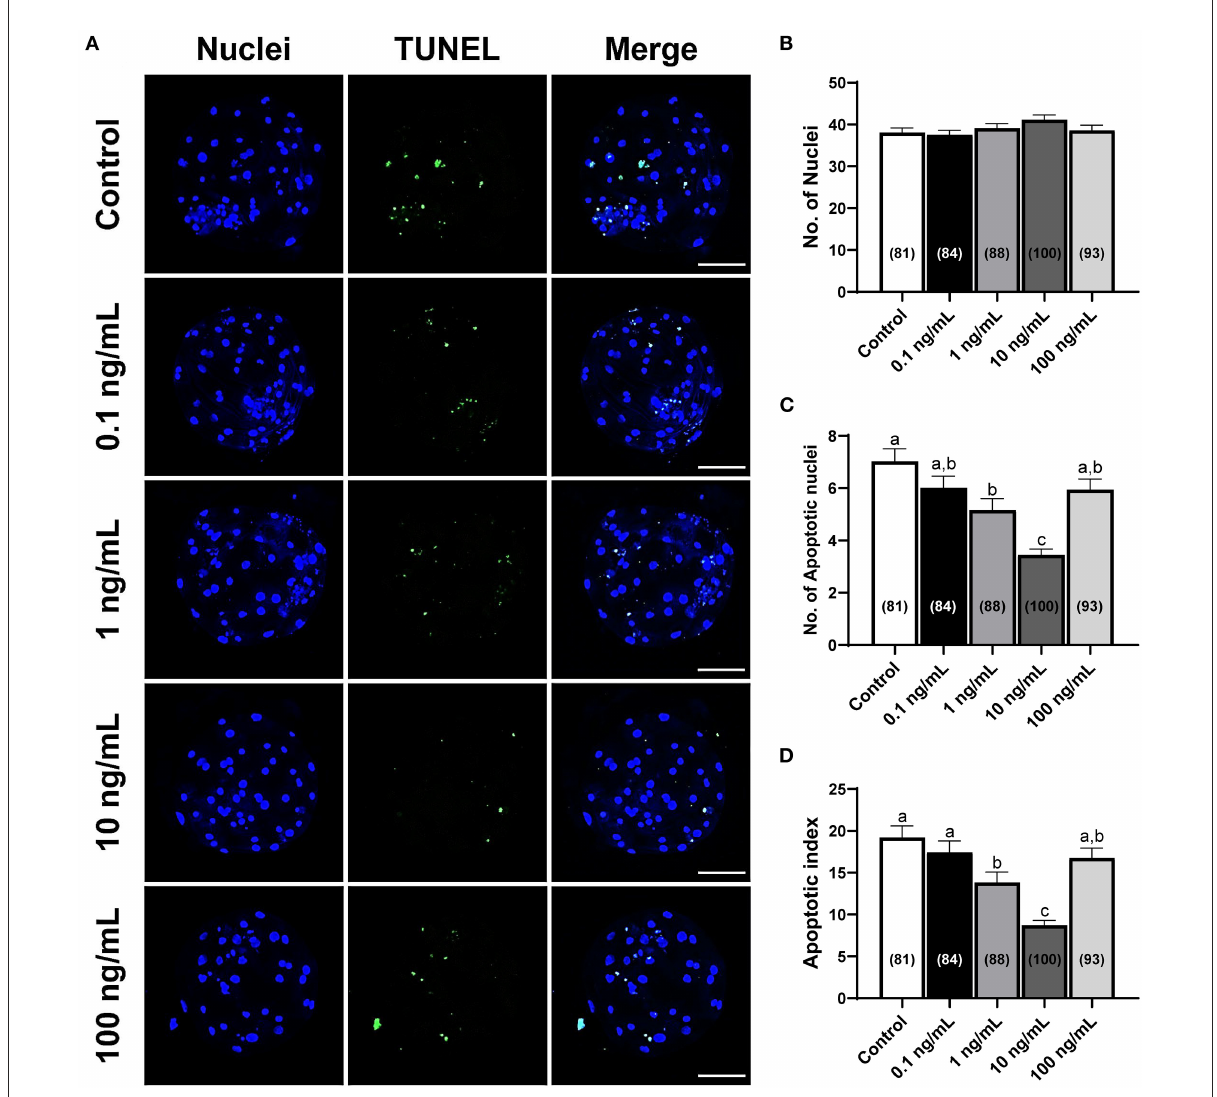
FIGURE4 Numbers of total cells and apoptotic nuclei in PA-derived blastocysts exposed to various concentrations of IL-7 supplementation during IVC for 7 days. (A) Representative laser scanning confocal microscopy images (200 × ) of porcine PA blastocysts labeled with Hoechst 33342 (Total nuclei, blue) and TUNEL (Apoptotic nuclei, green) after IVC. Scale bar: 100 µ m. (B–D) Quantification of total and apoptotic cell numbers, and apoptotic index in the indicated groups. The number of embryos examined in each experimental group is shown in parentheses. Within each endpoint, bars with different letters (a–c) are significantly different ( p < 0.05) for each group. For all graphs, the values represent the mean ± SEM. The experiment was replicated four